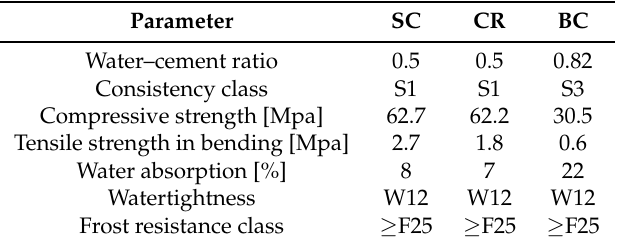
Table 5. Basic parameters of tested